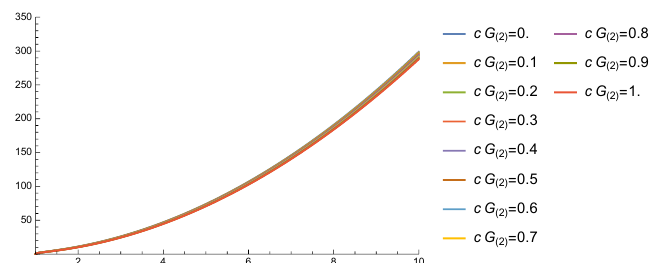
Figure 11. Y ( r ) for AdS-Schwarzschild black hole with the backreaction. The parameters are choosen as r = λ = λ = L = 1 , Λ = 10 r h p